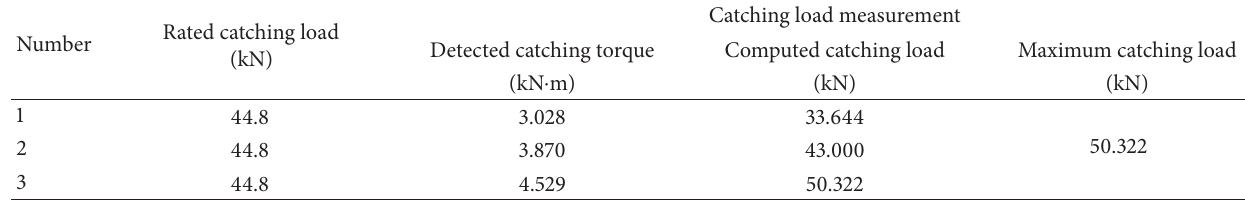
Table 10: Detected catching torque and the maximum catching load.